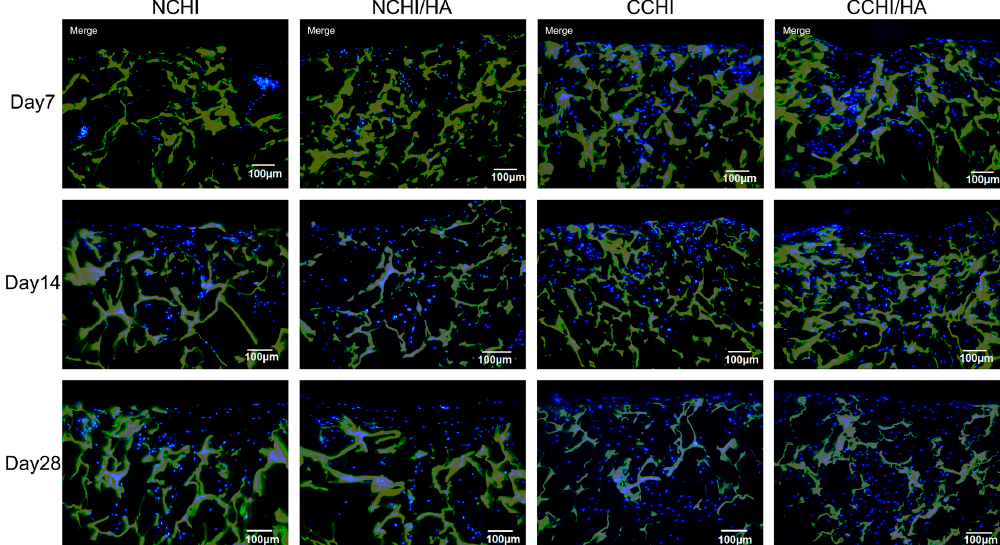
Figure 6. Immunofluorescence staining of collagen type I ( green ) at Day 7, 14, and 28 both in chitosan and chitosan with hyaluronic acid scaffolds with hADSCs cultured in normal (NCHI and NCHI/HA) or chondrogenic medium (CCHI and CCHI/HA). The chitosan and chitosan with hyaluronic acid scaffolds fluoresced yellow . Living cell nuclei fluoresced blue . Magnification set at 10×.